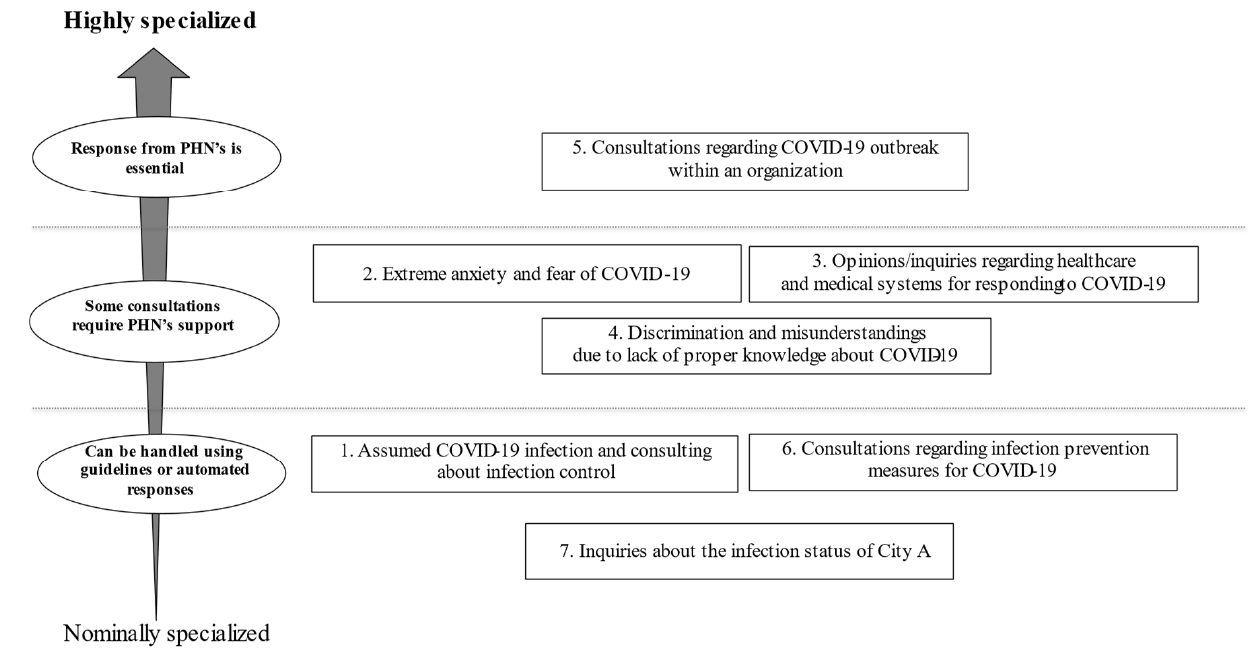
Figure 1. The categorization according to whether the PHNs needed to respond to the